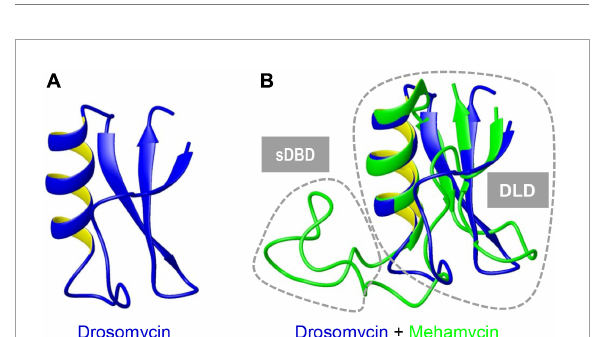
FIGURE2 Superimposition of mehamycin and drosomycin revealing their high structural similarity. Drosomycin (A) . Mehamycin and drosomycin (B) . Two distinct structural subdomains [single Disulfide Bridge-linked Domain (sDBD) and drosomycin-like domain, abbreviated as DLD] are indicated by dotted